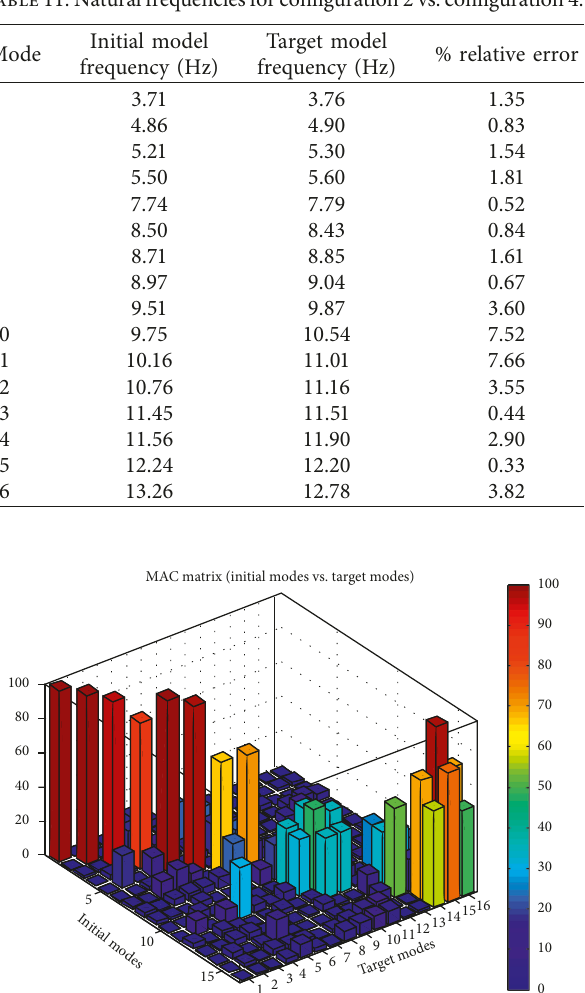
Figure 16: MAC of configuration 3. Table 11: Natural frequencies for configuration 2 vs. configuration 4.